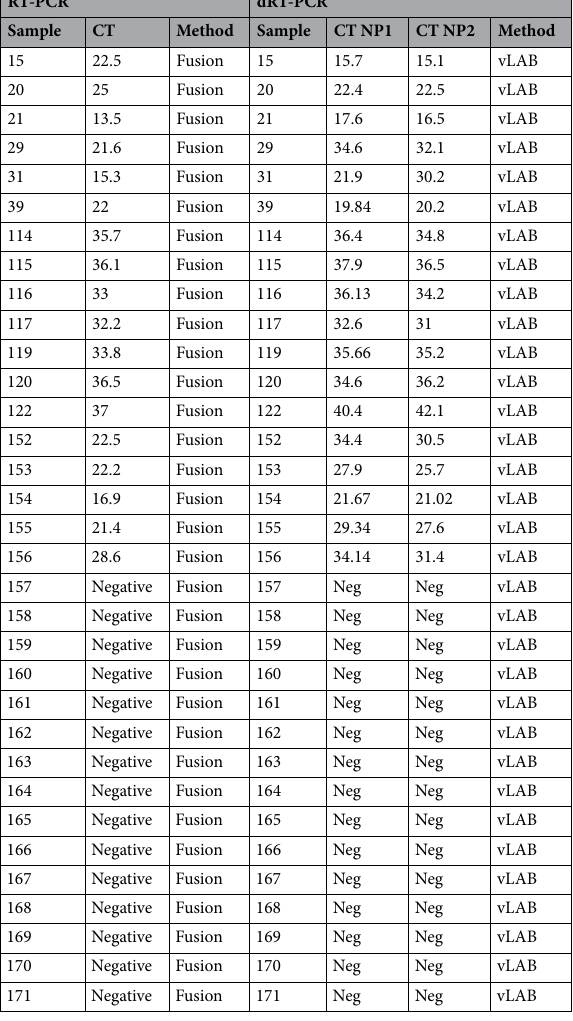
Table 4. RT-PCR vs dRT-PCR with vLAB. CT values of positive samples purified with fusion (left column) were compared with CT values of samples in vLAB amplified by dRT-PCR (right